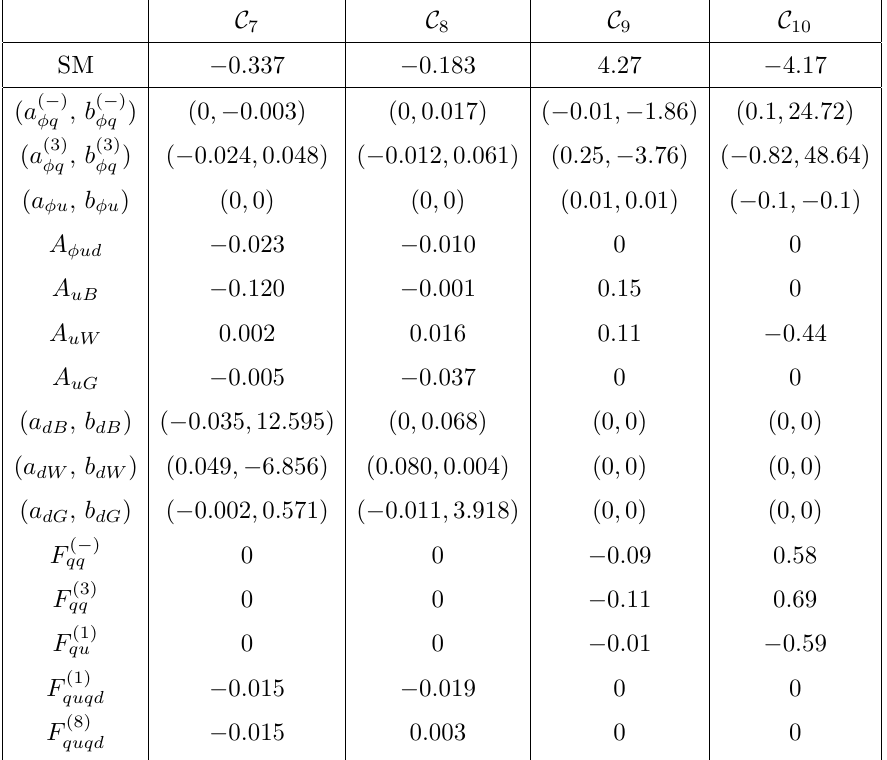
at LO in QCD. The b and C are not generated by 9 0 10 0